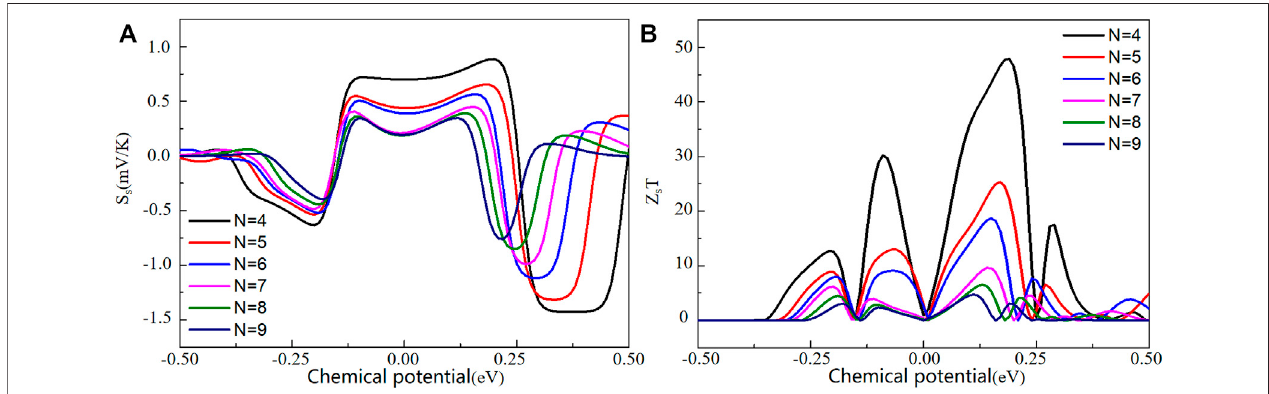
FIGURE 6 | (A) The spin thermopower (S s ), (B) spin fi gure of merit (Z s T) versus chemical potential for the N-ZKGeNRs (N = 4 – 9).